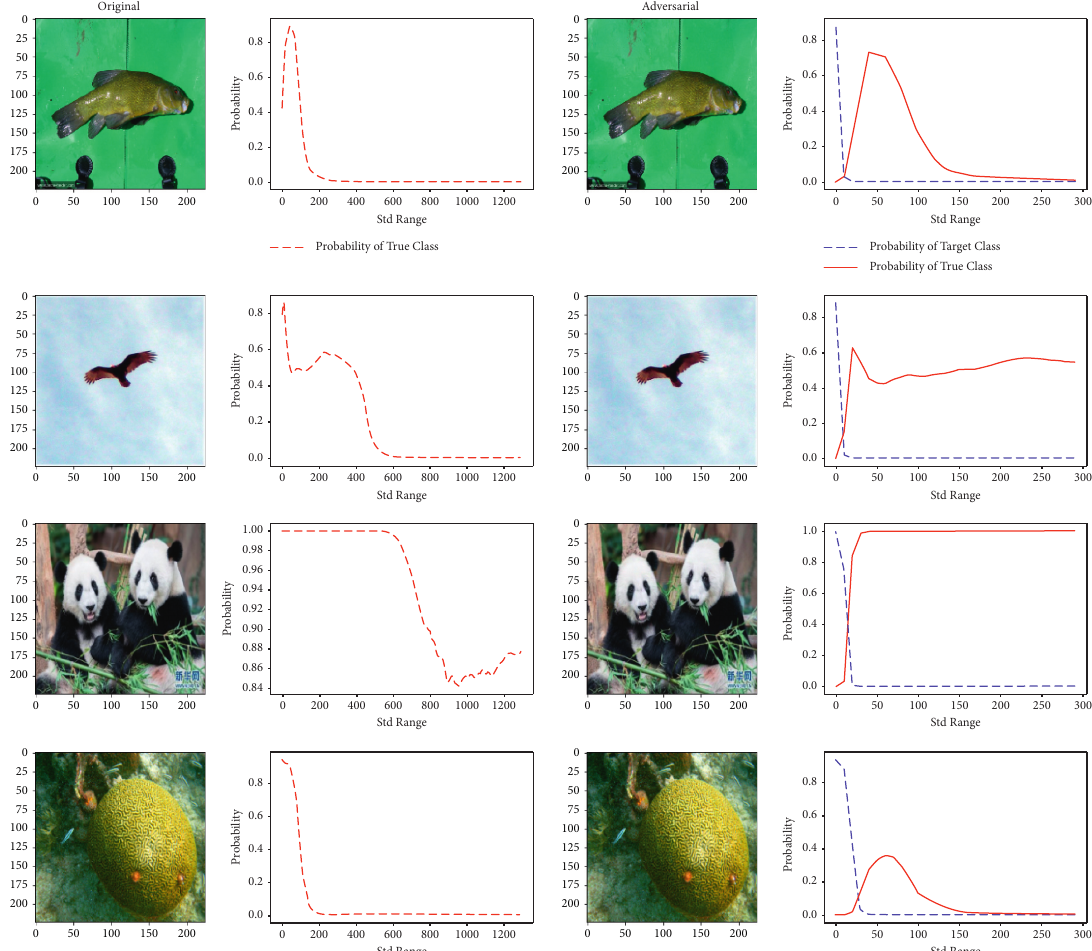
Figure 4: The image classification results vary significantly with different filter variances (std: standard Step 2: a cyclic body aims to obtain the classification